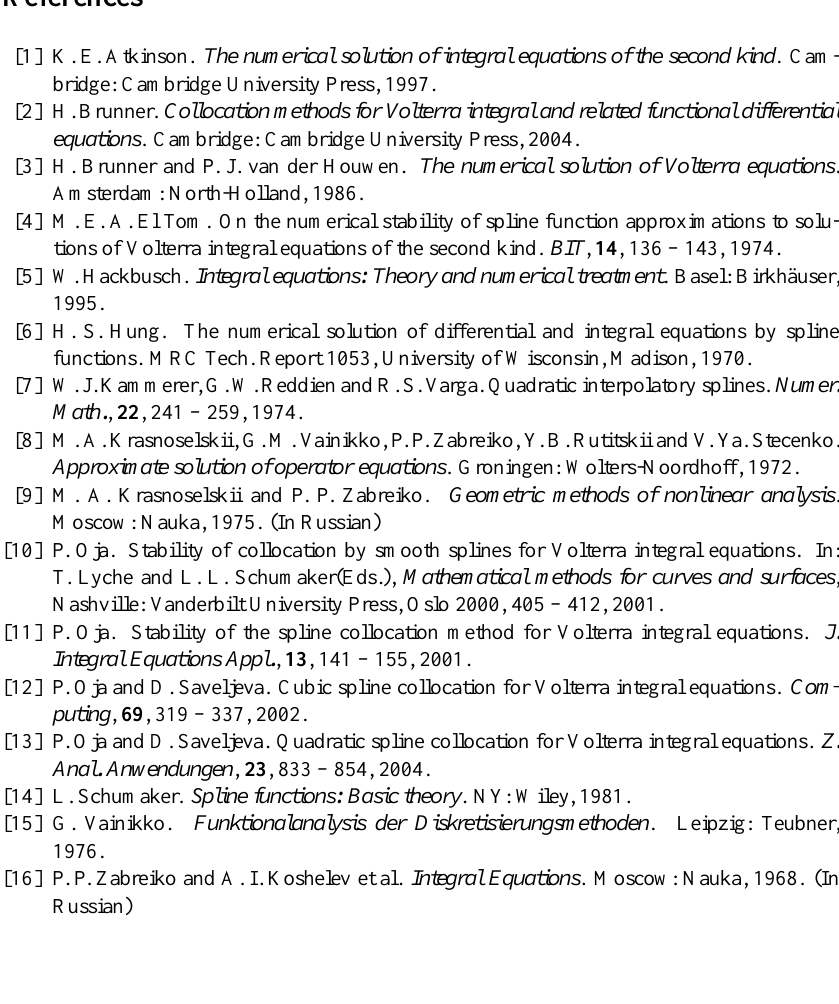
Table 2. Numerical results for y ( t ) = (cid:21) R t N 4 16